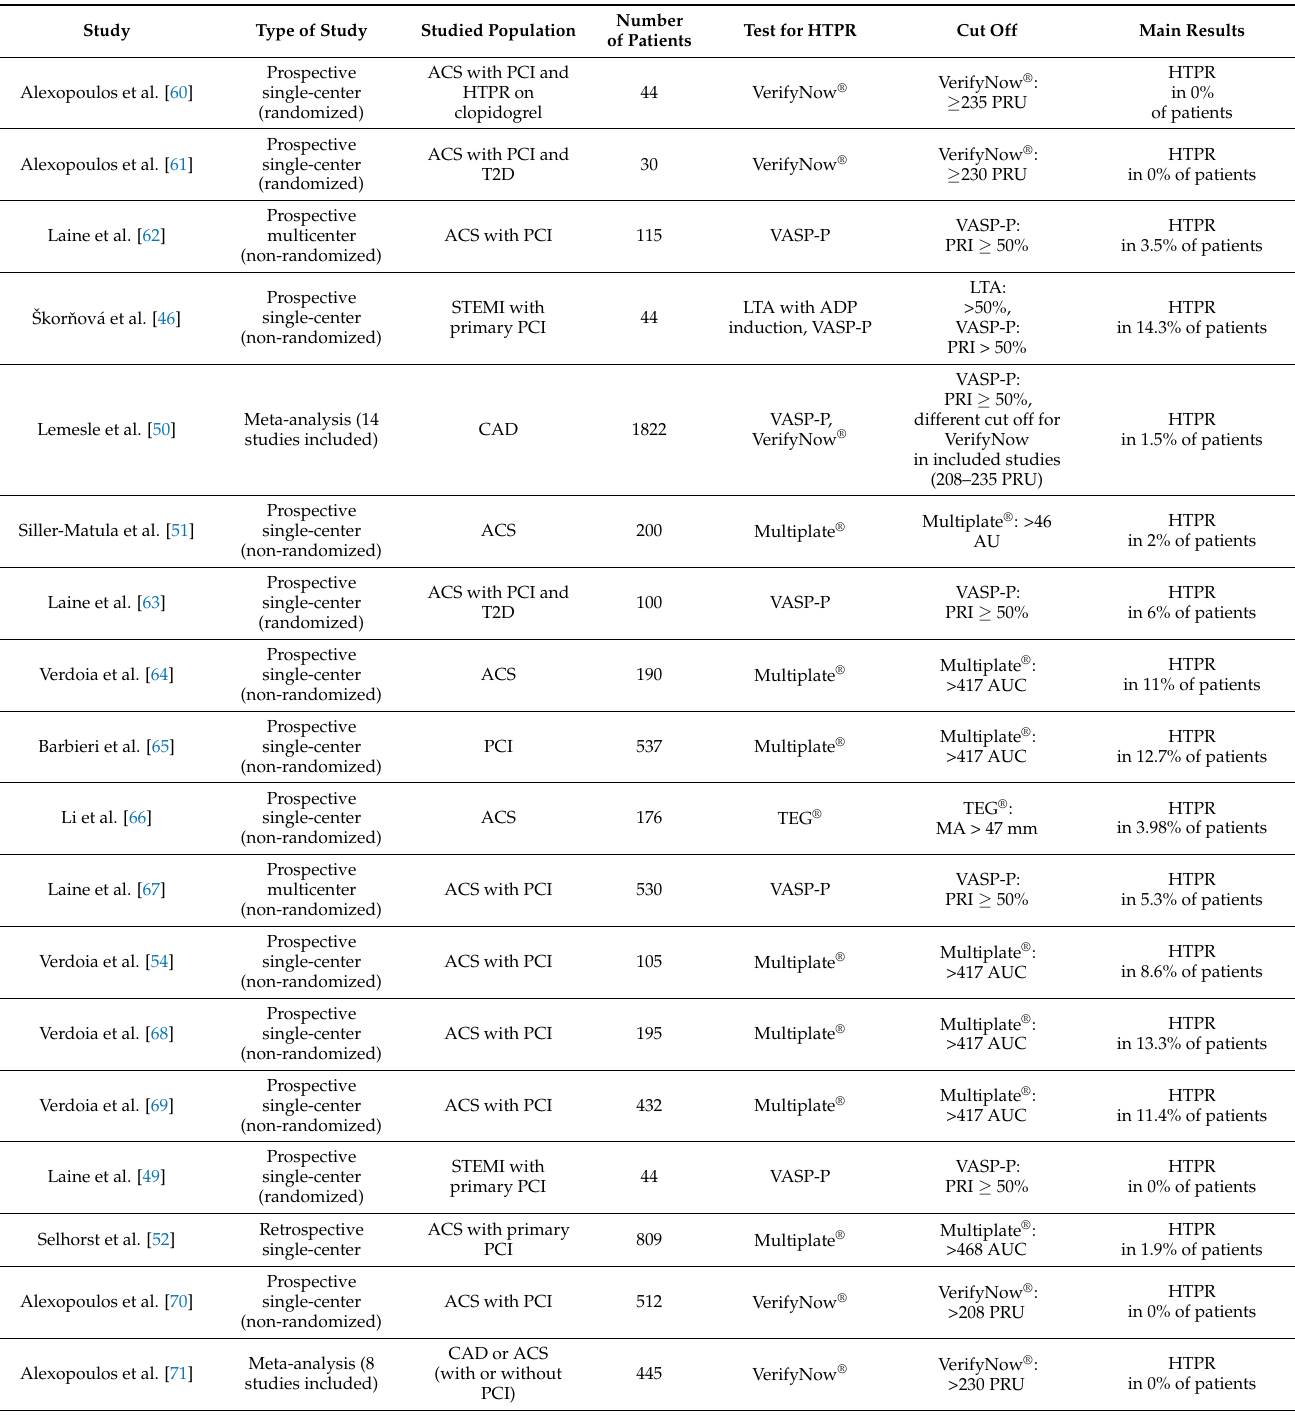
Table 3. Summary of studies reporting ticagrelor